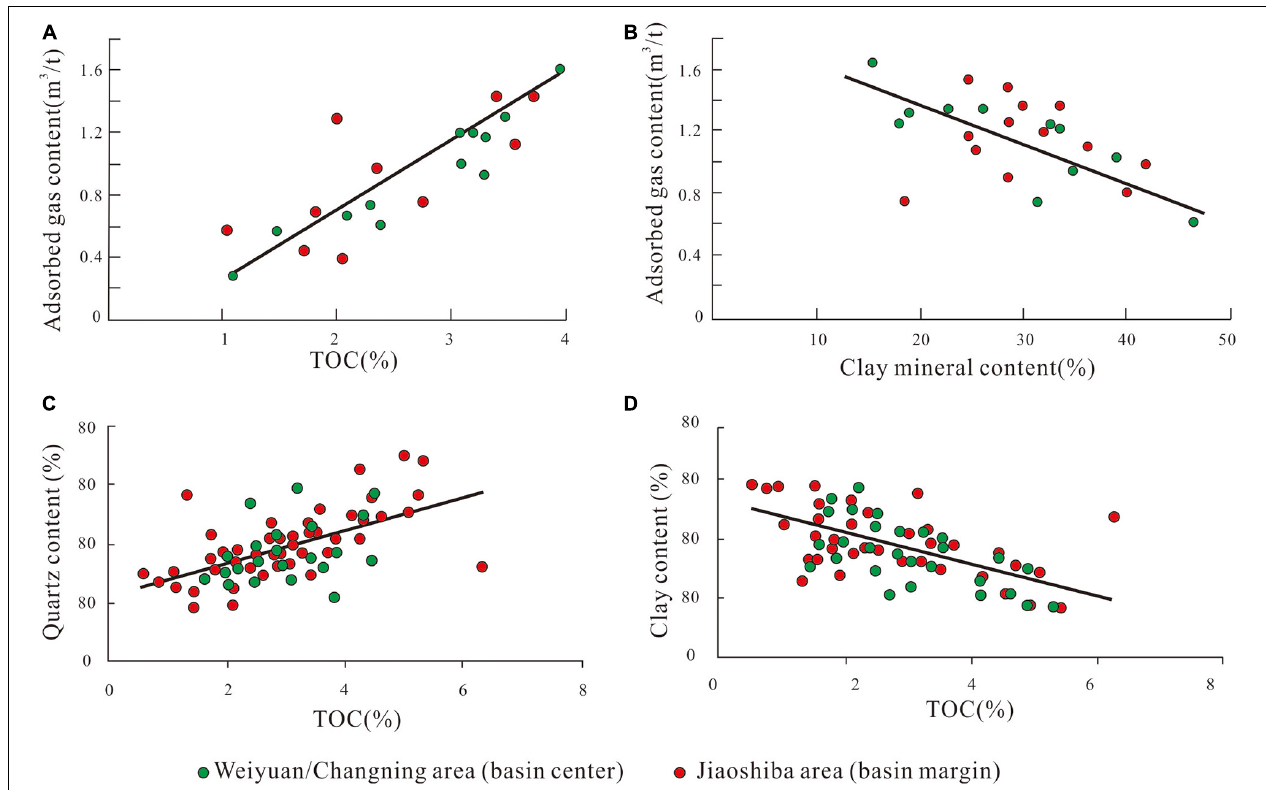
FIGURE 9 | Relationship maps between absorbed gas content and total organic carbon (TOC) and mineral content in the Sichuan Basin (the data of Jiaoshiba area was referenced from Guo et al. (2014)). (A) A scatter diagram of TOC and absorbed gas content. (B) A scatter diagram of absorbed gas and clay mineral content. (C) A scatter diagram of quartz content and TOC. (D) A scatter diagram of clay mineral content and